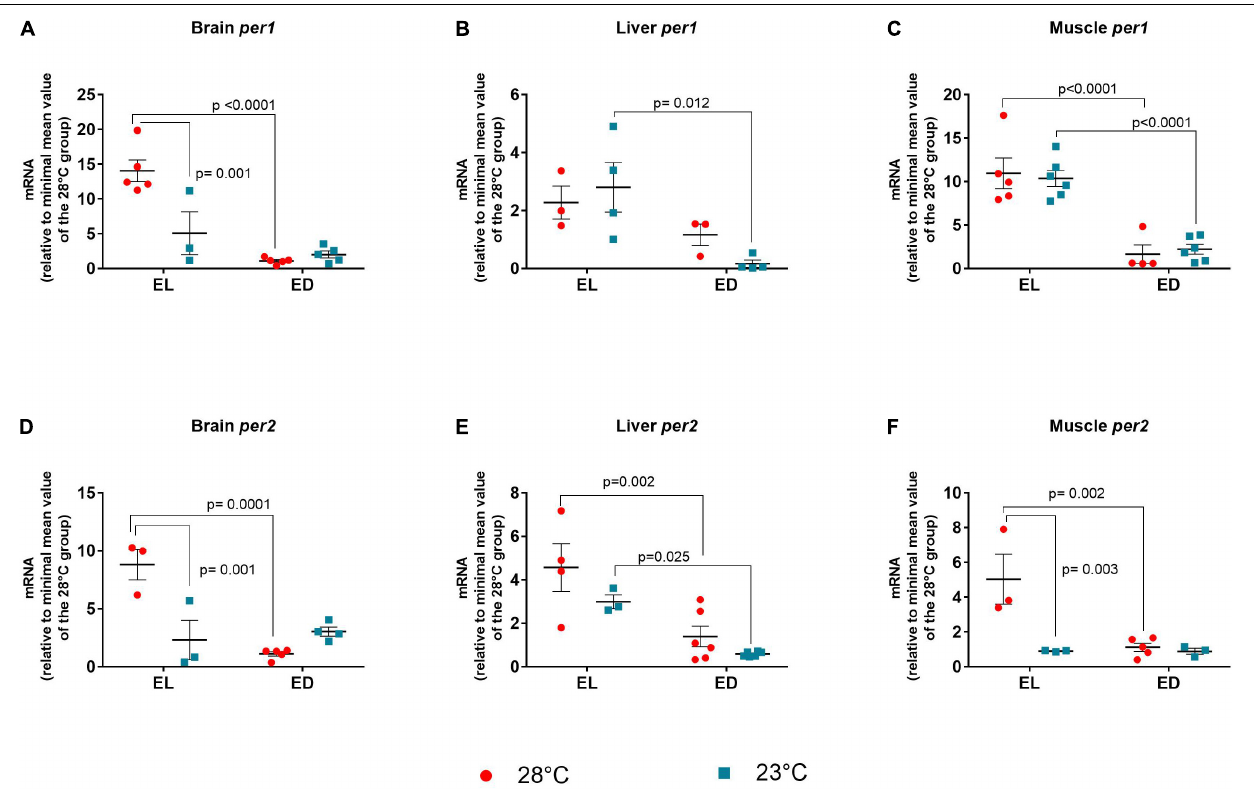
FIGURE 6 | Early light (EL) and early dark (ED) expression of period ( per1 and per2 ) genes in adult Danio rerio . (A) Brain per1 ; (B) liver per1 ; (C) muscle per1 ; (D) brain per2 ; (E) liver per2 ; (F) muscle per2. The gene expression was normalized by the 18S rRNA and expressed relative to the lowest mean of the control temperature group. The values are expressed as mean ± SEM. n = 3–6 (pools of four animals each). Significant differences are shown when p < 0.05. Red symbol corresponds to 28 o C and blue symbol corresponds to 23 o